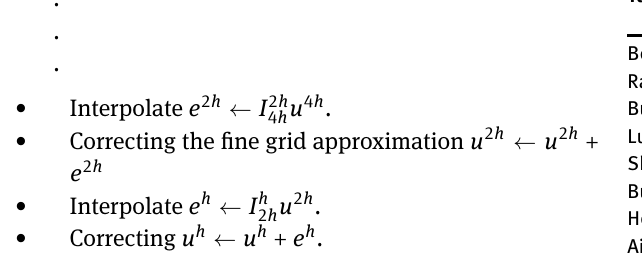
Table 1: Bearing variables used in the